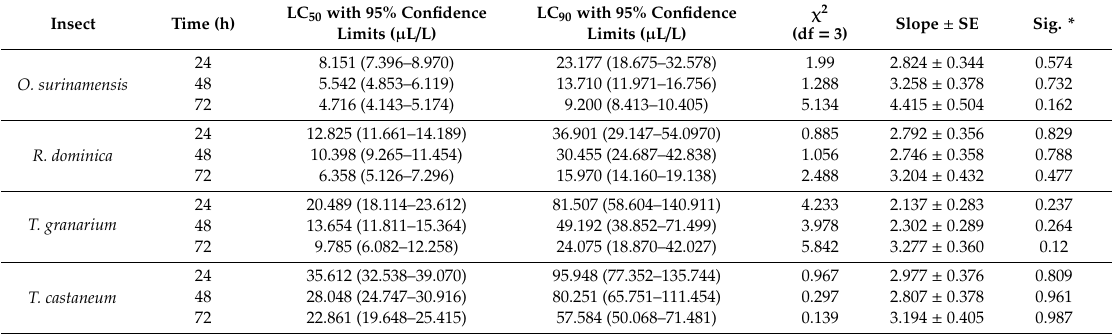
Table 3. Probit analysis of the data obtained from fumigation of Satureja intermedia essential oil on the adults of Oryzaephilus surinamensis , Rhyzopertha dominica , Tribolium castaneum , and Trogoderma granarium . LC 50 with 95% Confidence Insect Time (h) Limits ( µ L /